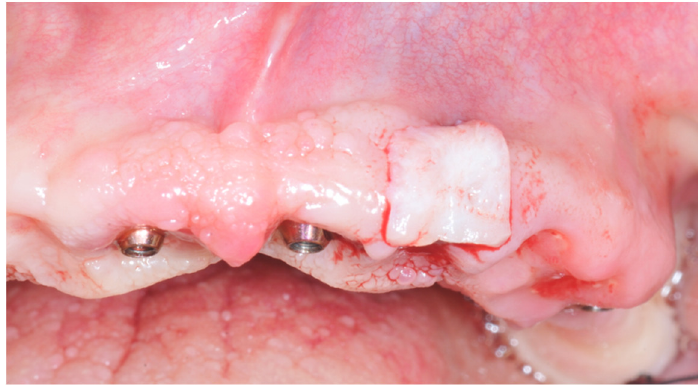
Figure 6. Soft tissue graft performed after 4 months to increase thickness in the 2.2 pontic area.